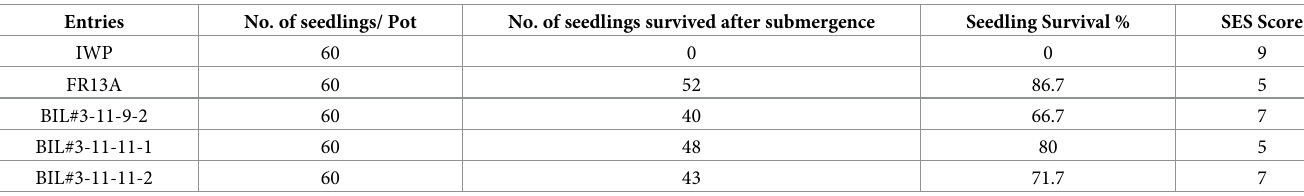
Table 8. Performance of BILs and parents against submergence